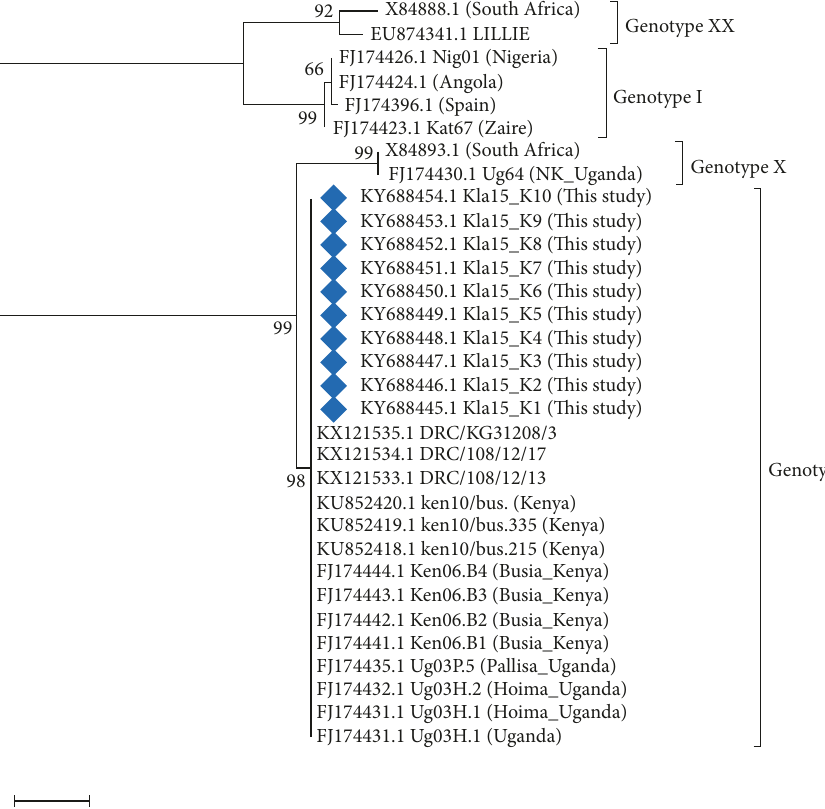
Figure 3: Phylogenetic tree constructed using full-length p54 sequences from this study and other sequences from the gene bank. All genotypes are represented. A maximum likelihood p54 gene tree was inferred using the K2P model of sequence evolution [22]. The analysis involved a total 32 nucleotide sequences. There were a total of 576 positions in the final dataset. Sequences from this study are denoted by Blue diamond.